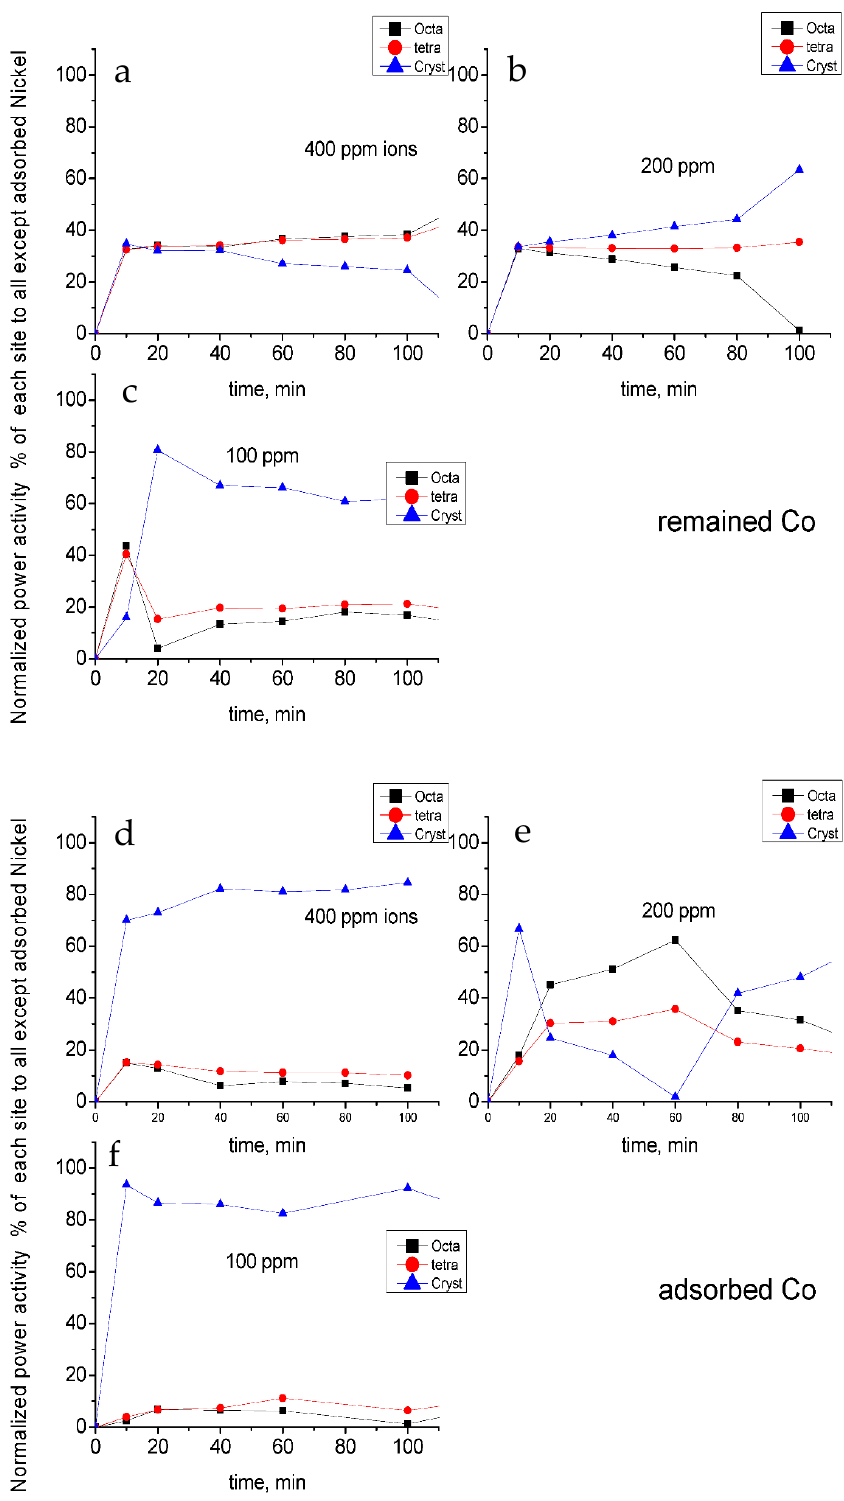
Figure 14. Effect of remained and adsorbed cobalt ions on the power activity map: ( a ) 400 ppm remained; ( b ) 200 ppm remained; ( c ) 100 ppm remained; ( d ) 400 ppm adsorbed; ( e ) 200 ppm adsorbed; ( f ) 100 ppm